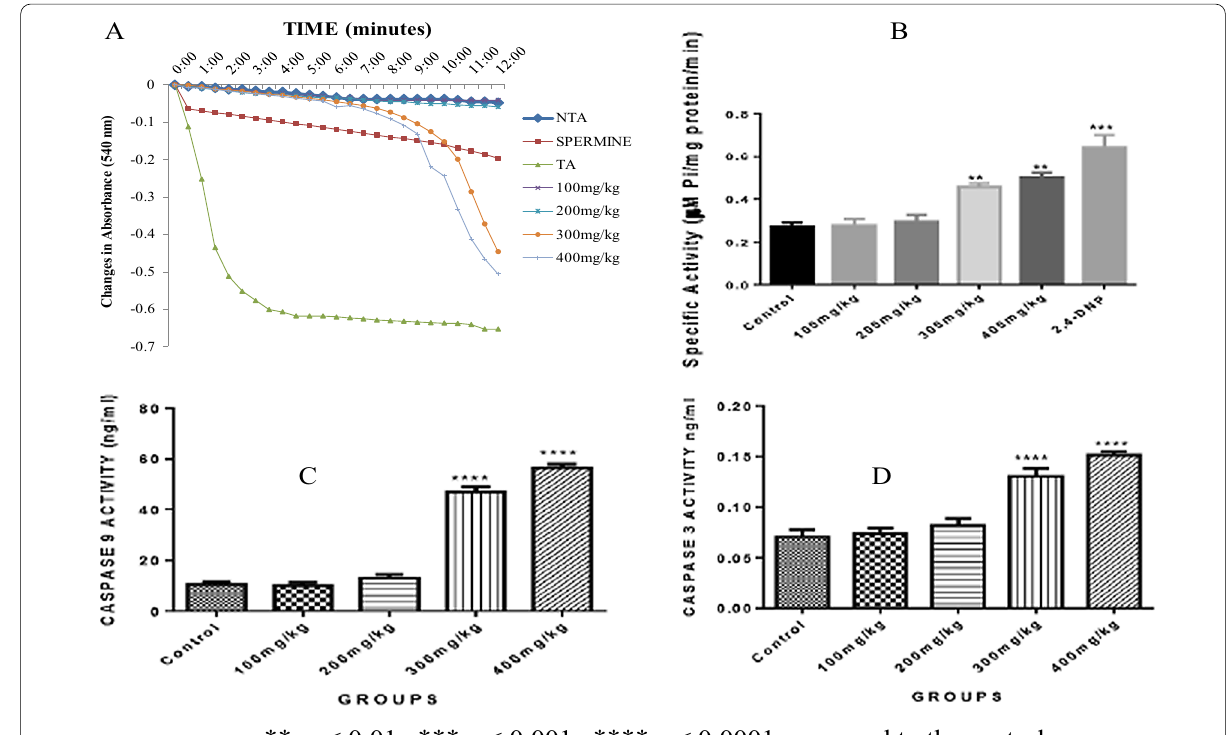
Fig. 2 Effects of varying doses of metformin on rat uterus mPT pore opening (representative profile) ( a ), mATPase activity ( b ), caspase 9 ( c ) and caspase 3 ( d ) activities after 30 days of